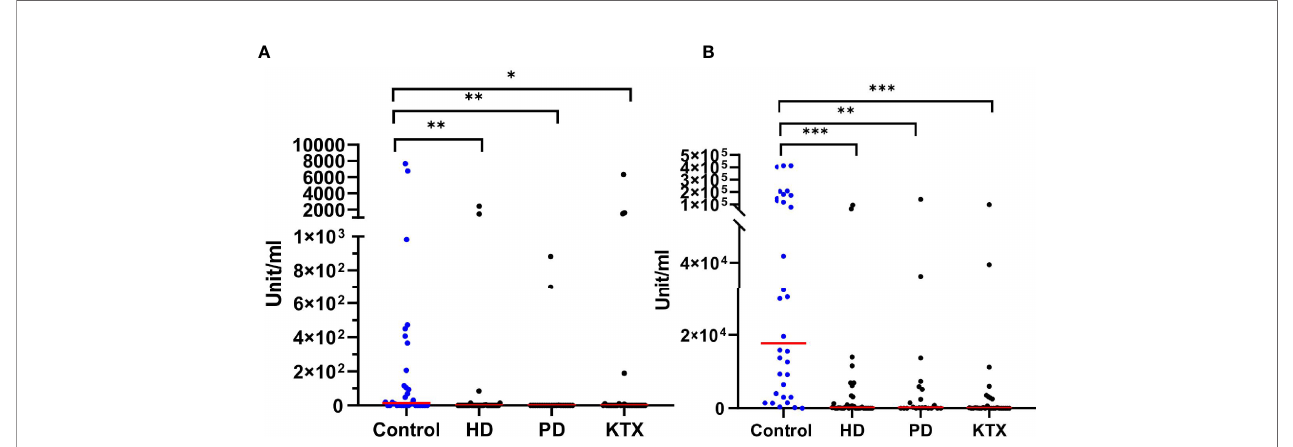
FIGURE 3 | The level of anti-S IgA (unit/ml) after the fi rst (A) and the second (B) dose of BNT162b2 vaccine The p-value was calculated with the use of the Kruskal – Wallis test. Dunn ’ s multiple comparison test with the reference to the control group (highlighted in blue) was used as a post-hoc test. The red line indicates the median. Signi fi cant results are marked with * (p<0.05), ** (p<0.01), or *** (p<0.001). After the fi rst (A) as well as the second (B) dose of vaccine, we detected differences between the control group and patients with renal disorders. We did not observe any statistical signi fi cance among renal disease patients both after the fi rst and second dose of vaccine. HD, hemodialysis; PD, peritoneal dialysis; KTX, kidney